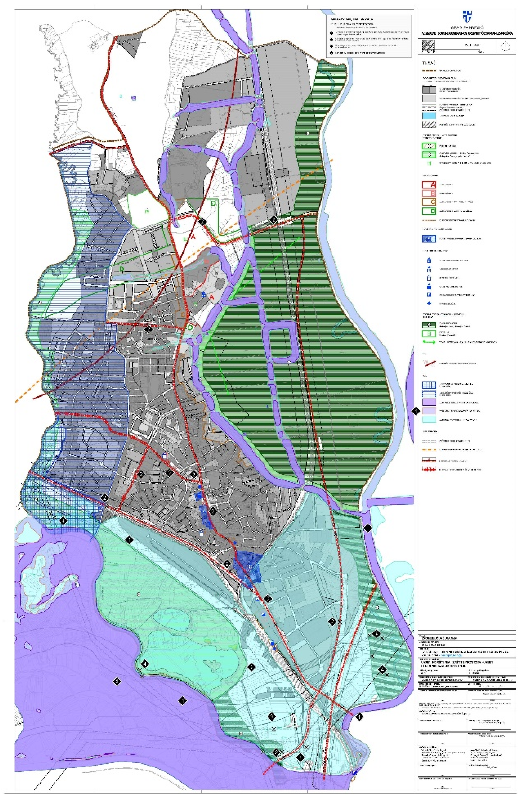
Figure 2. The city of Zapreši ć general urban plan. Despite decent energy potential, the city has a virtually non-existent power sector. The city consumes an average of 262 GWh of energy per year. Almost 60% of its energy is used for heating purposes. The annual energy demand of the city is shown in Figure